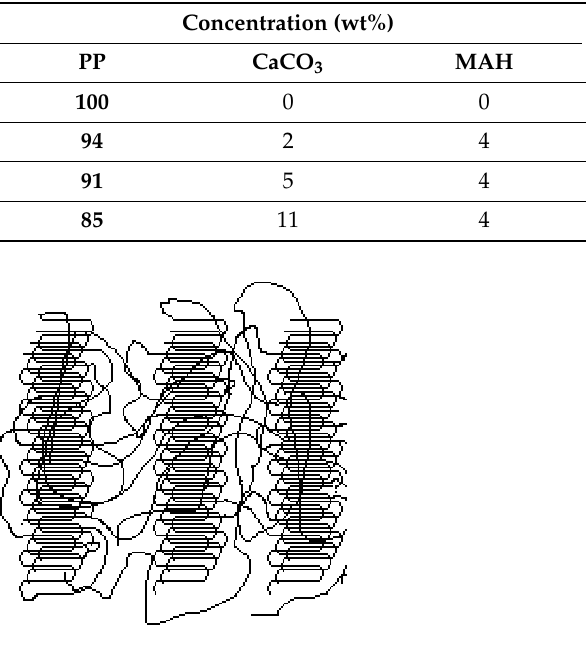
Table 1. Impact Results for the nano-CaCO 3 Samples with 4 wt% MAH.